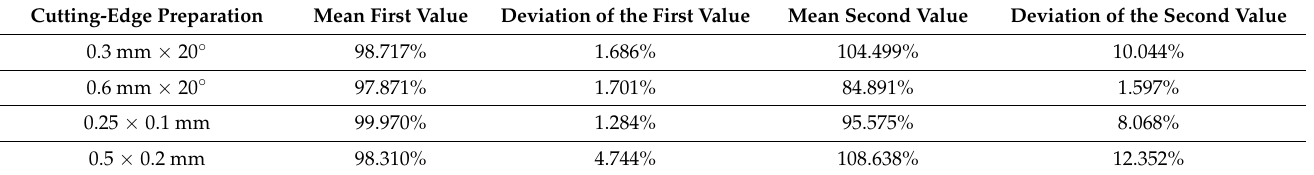
The results recorded in Table 5 are visualized in Figure 9. The blue color represents the mean first value (in percentages), and the orange color represents the mean second value (also in